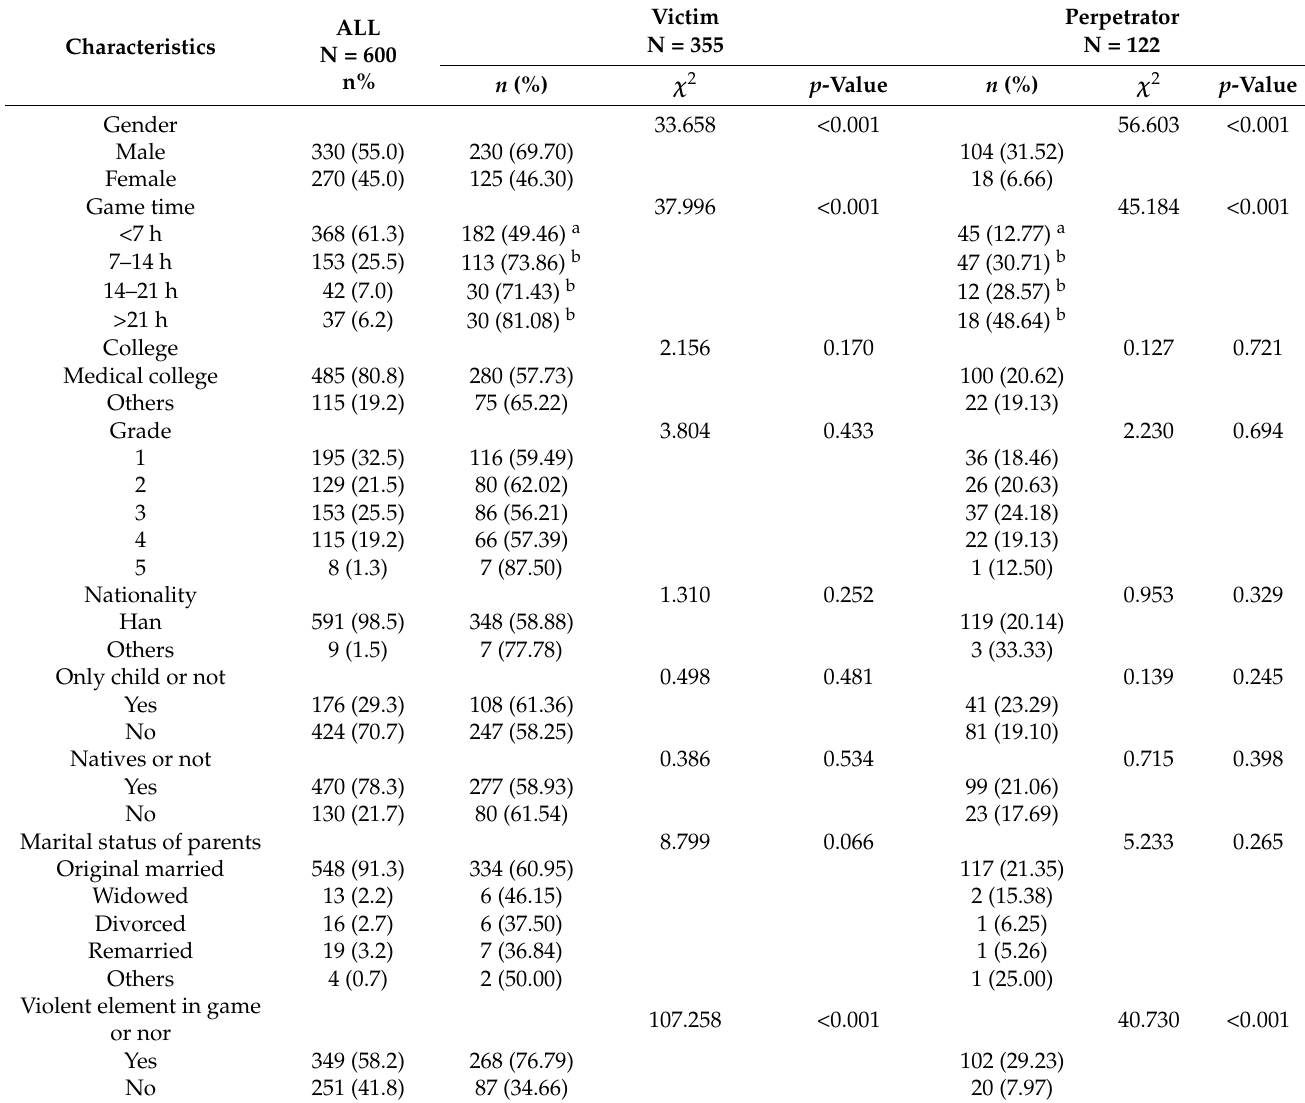
Table 3. Univariate analysis of cyberbullying in online games among college